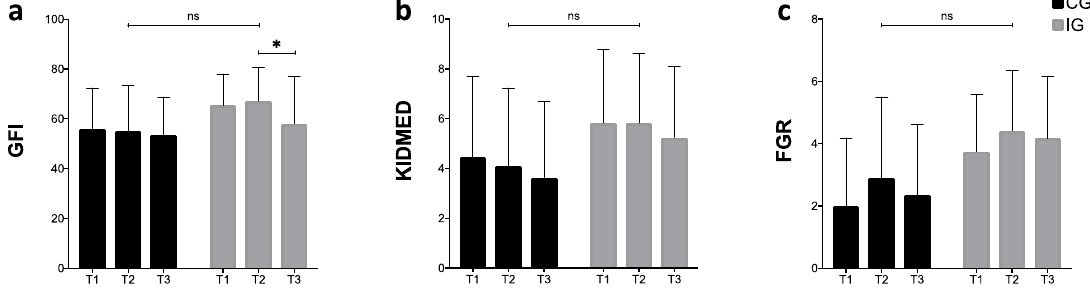
Figure 4. Intra and inter-group values between CG and IG at T1, T2, and T3. ( a ) GFI: global food index; ( b ) KIDMED: Mediterranean diet quality index; ( c ) FGR: food guide recommendations; CG: control group; IG: intervention group; NH: national holidays; * Statistical significance ( p < 0.05); NS: no significance.